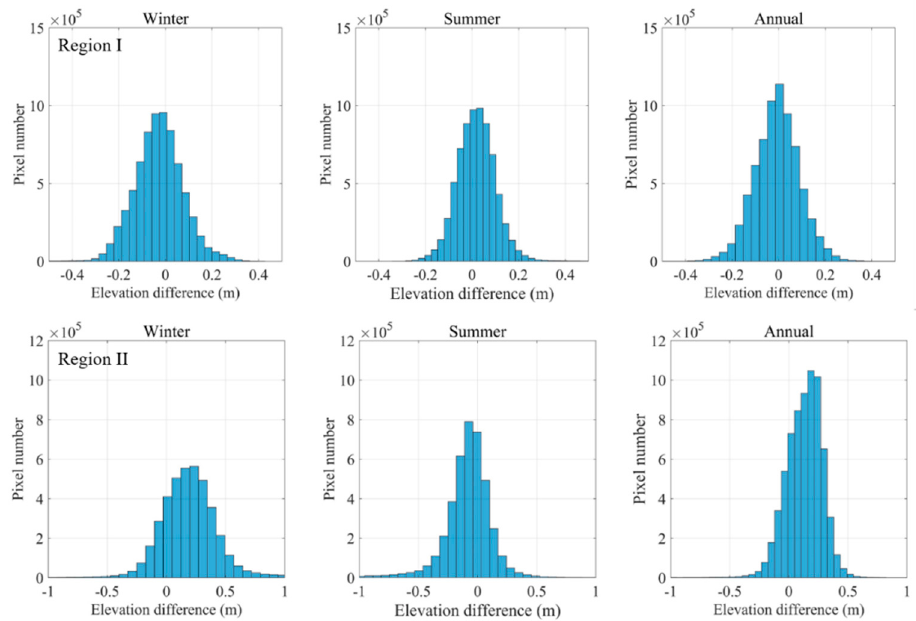
Figure 4. Histograms of elevation differences in cold season (winter), warm season (summer) and annual scale for the selected off-glacier region (Region I in the upper and Region II in the lower) in the front/lateral of Parlung No. 4 Glacier.